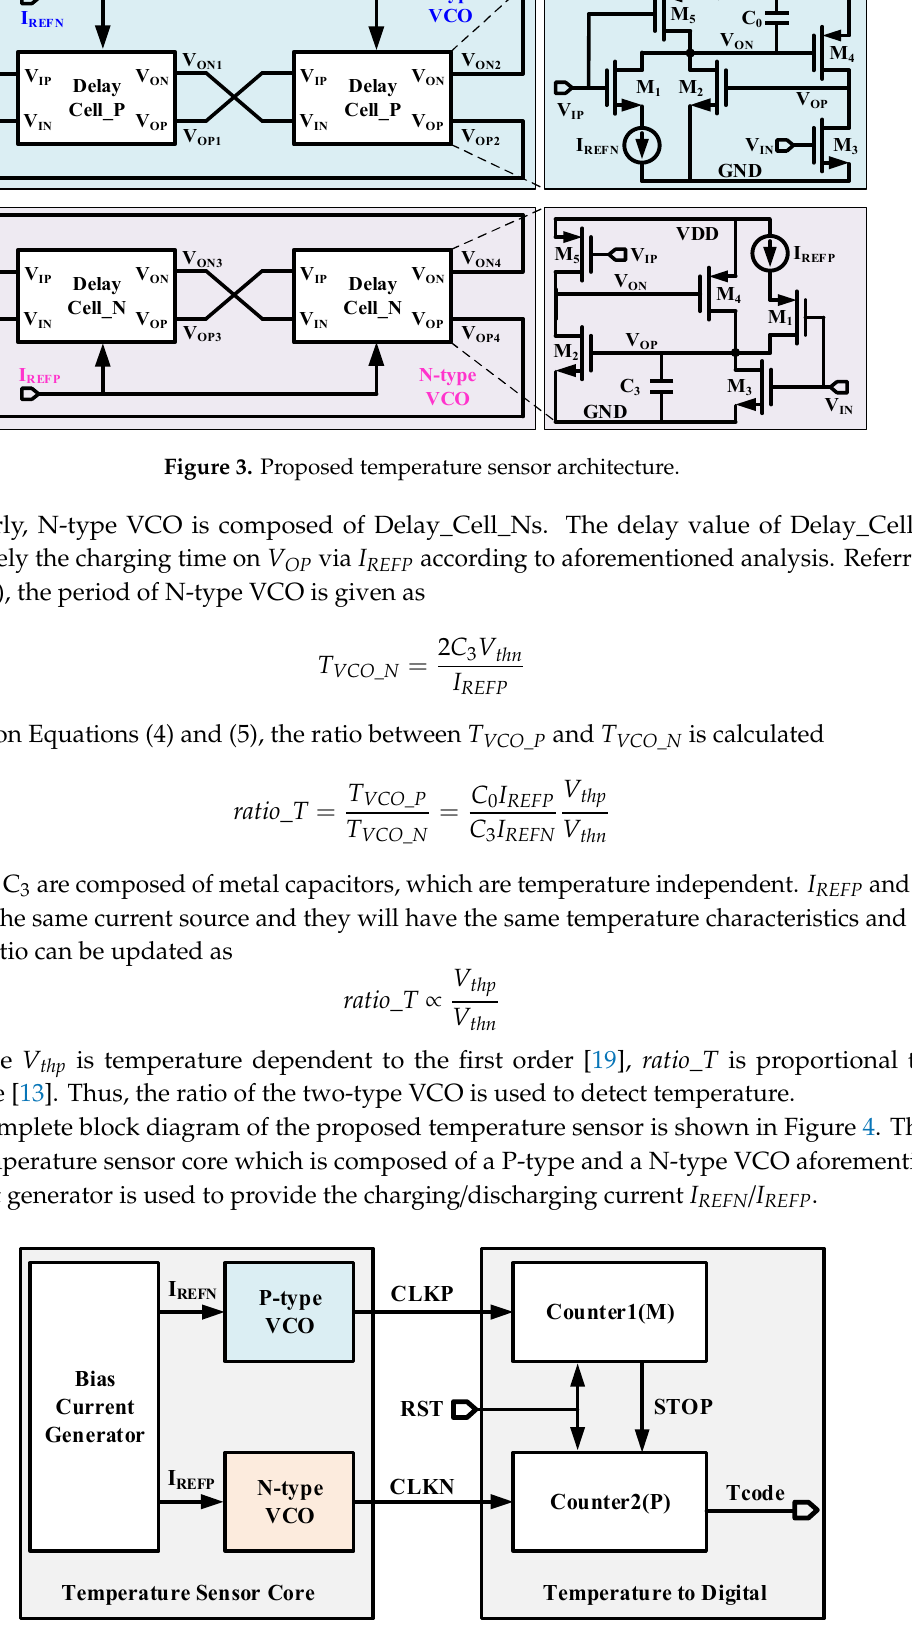
Figure 4. Block diagram of the temperature